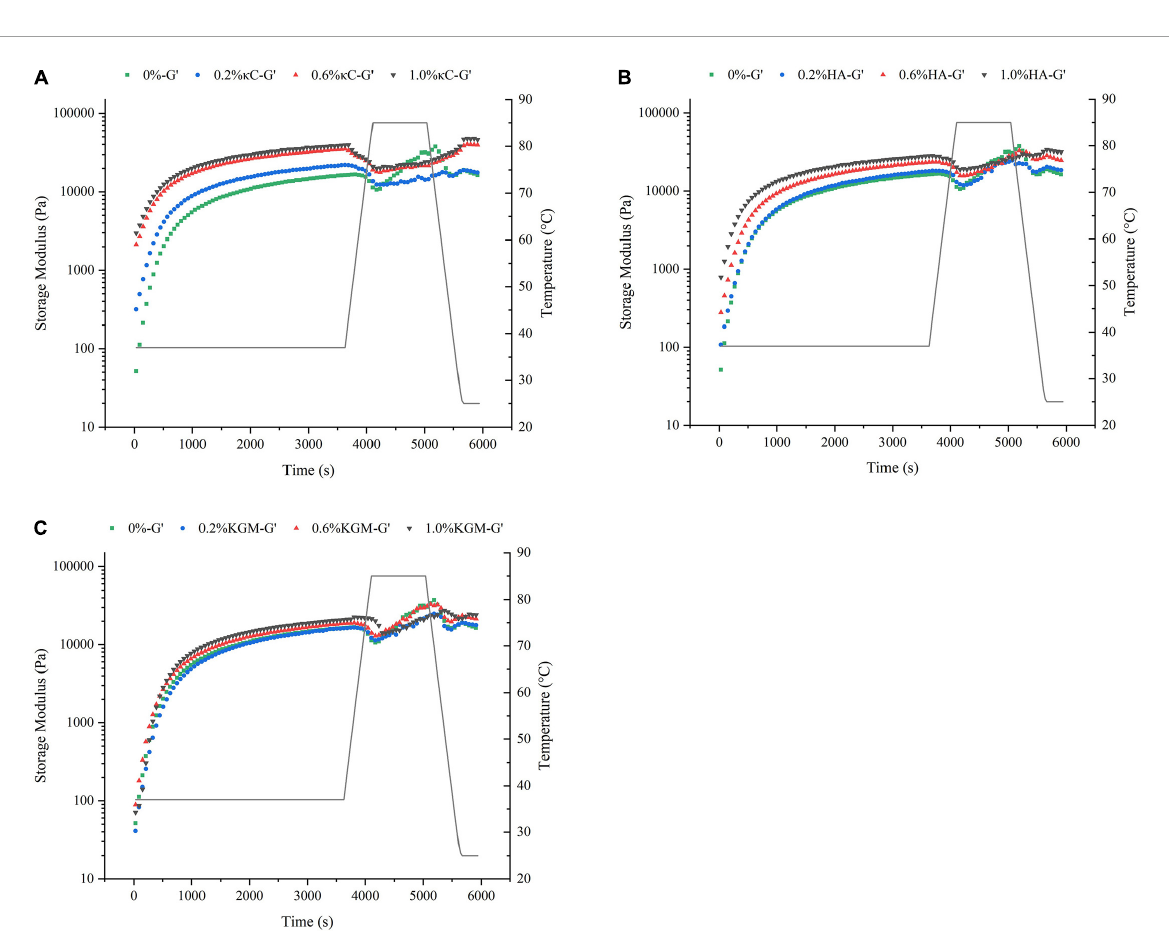
Frontiers in Nutrition